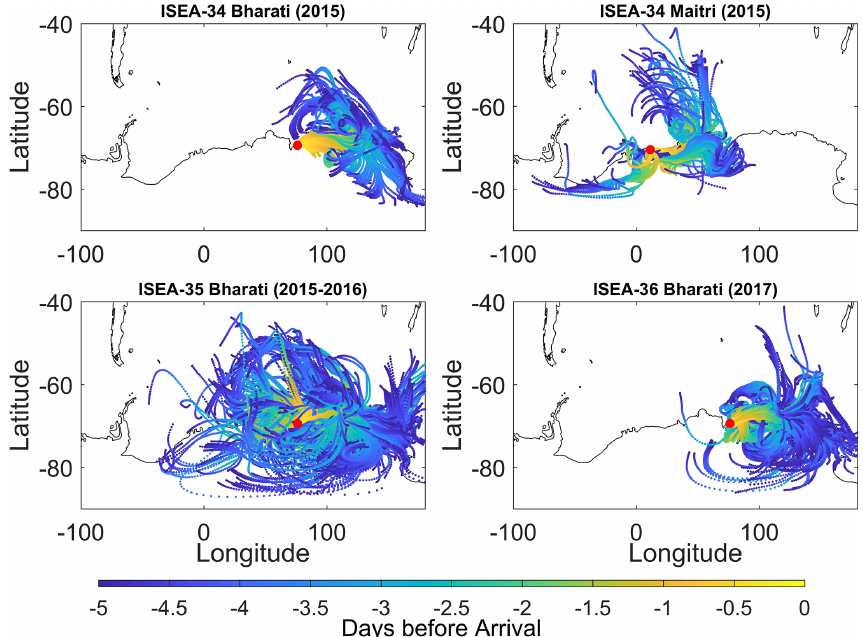
Figure 2. The 5d back-trajectories arriving at the two stations on the days that the measurements of IO were conducted as a part of the 34th, 35th, and 36th ISEA expeditions are shown. The back-trajectories were calculated using the HYbrid Single-Particle Lagrangian Integrated Trajectory (HYSPLIT) model, arriving every hour (Draxler and Rolph,